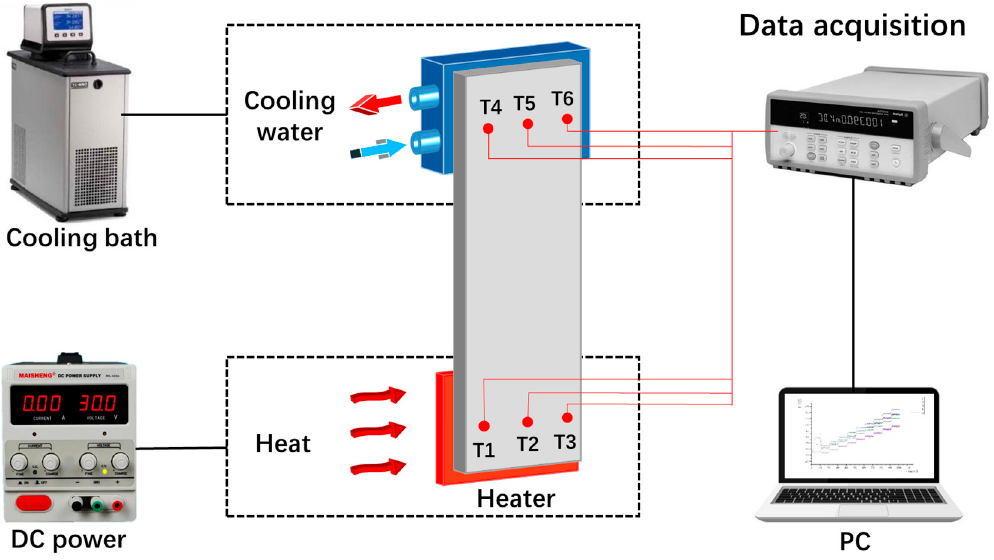
Figure 2. Schematic diagram of the experimental setup for thermal performance of the FOHP.